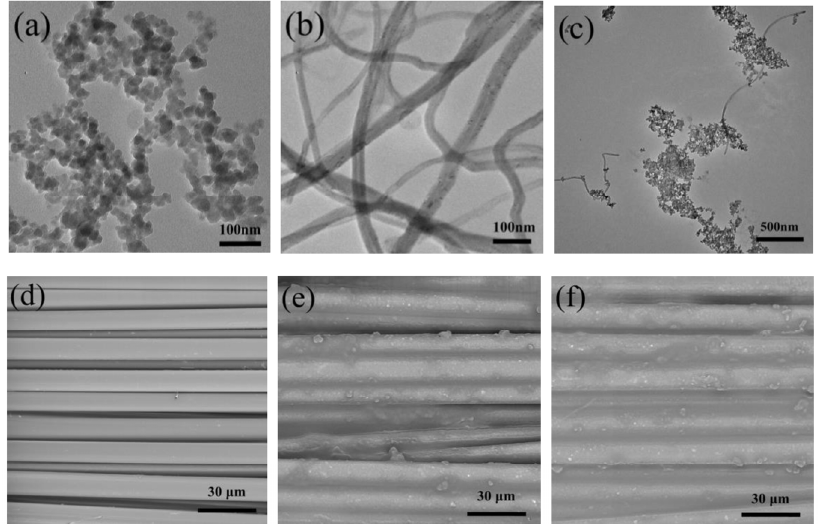
Figure 12. TEM images of ( a ) fumed silica nanoparticles, ( b ) O 2 -plasma treatment MWNTs and ( c ) fumed silica nanoparticles and M-MWNTs, SEM images of ( d ) neat Kevlar fabric, ( e ) STF/Kevlar fabric, and ( f ) M-MWNT/STF/Kevlar fabric. Reprinted from [102], Copyright (2018) by the authors, originally published under a CC-BY license.